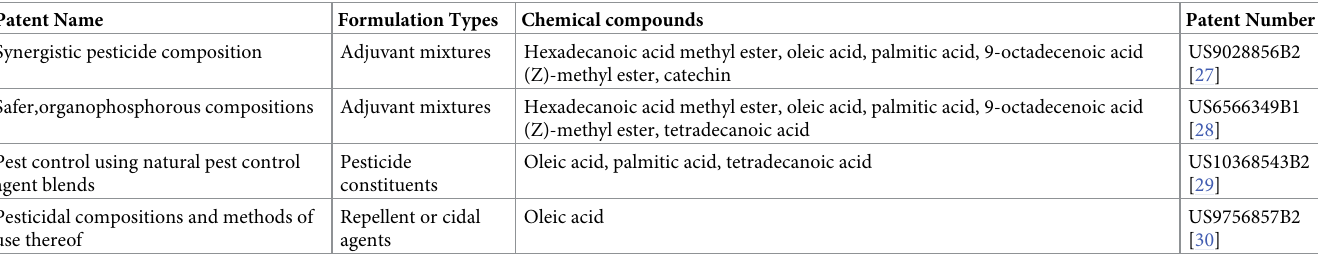
Table 3. Potential utilization of chemical compounds within A . catechu nut for pesticide